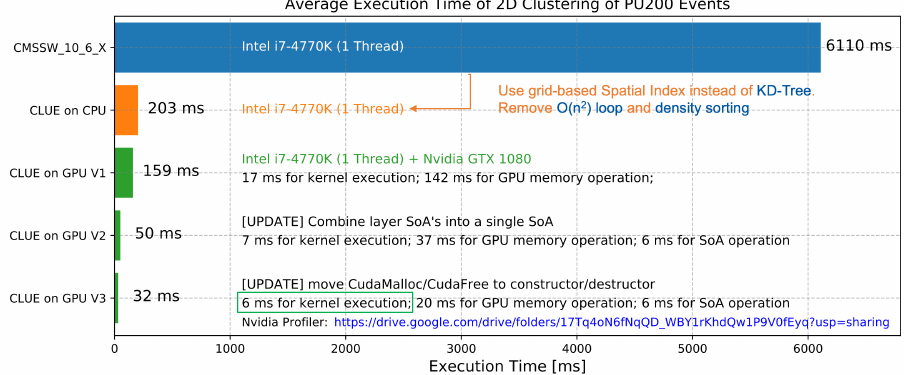
Figure 5. Average execution time of HGCAL clustering for PU200 events. The testing platform is based on Intel i7-4770K CPU and NVIDIA GTX 1080 GPU. Blue, orange and green bars represent ex- ecution time of CMSSW_10_6_X, CLUE-CPU and CLUE-GPU respectively. Both CMSSW_10_6_X and CLUE-CPU use a single CPU thread. Three green bars are three evolving versions of CLUE-GPU and the most updated one is version 3 with 32 ms execution time, shown as the bottom-most green